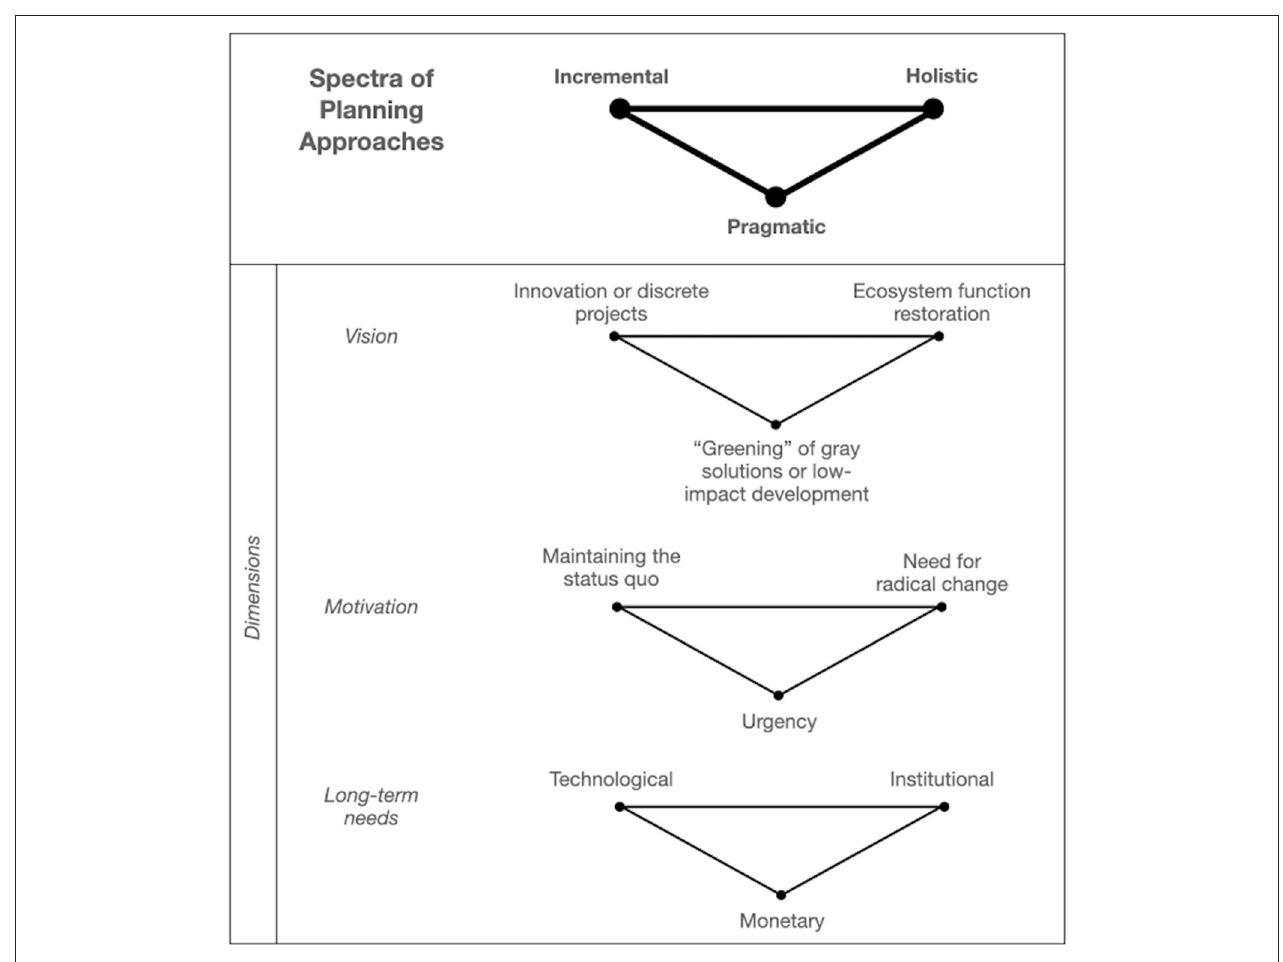
FIGURE 4 | A framework to understanding various approaches to stormwater planning.